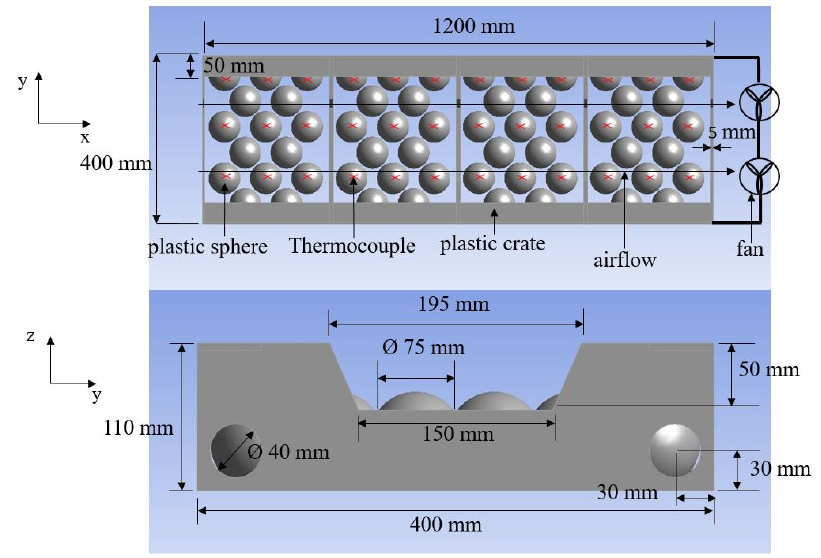
Figure 2. Illustration of the dimensions and the arrangement of the crates and carrageenan spheres.